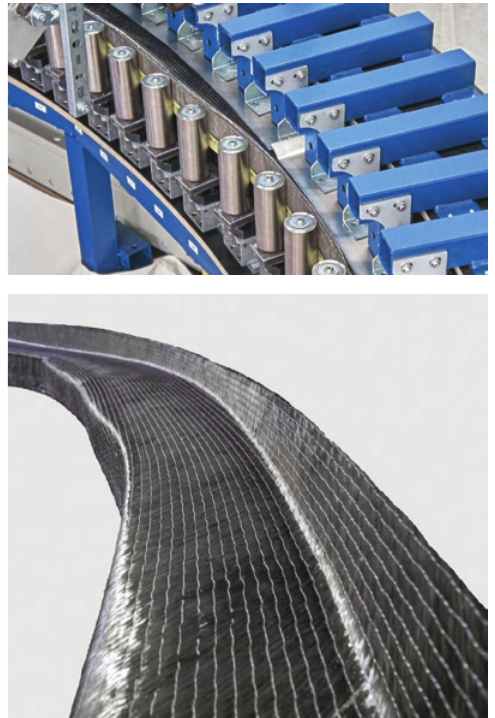
Figure 9: Facility for continuously adjusting the cross-sectional geometry of profile preforms (top) and Z-shaped profile preform, axially curved and with variable profile base length (bottom). Source: IDVA